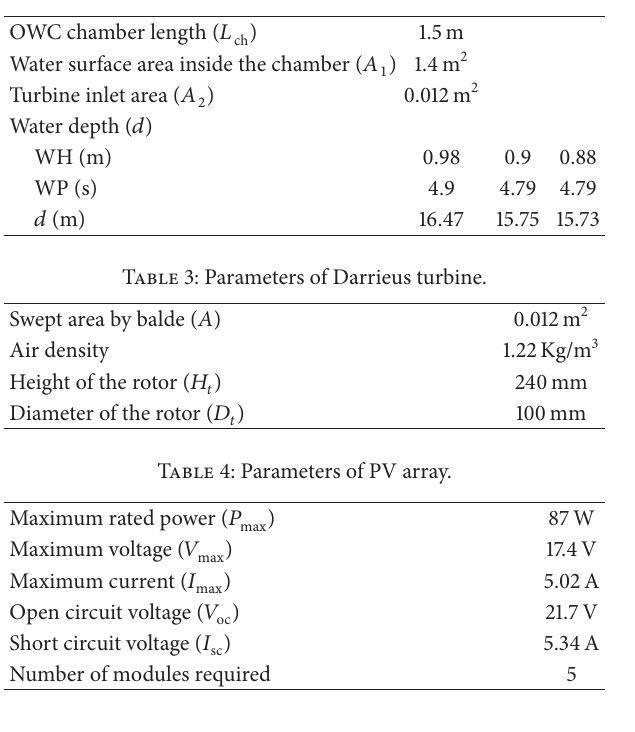
Table 2: Parameters of OWC.